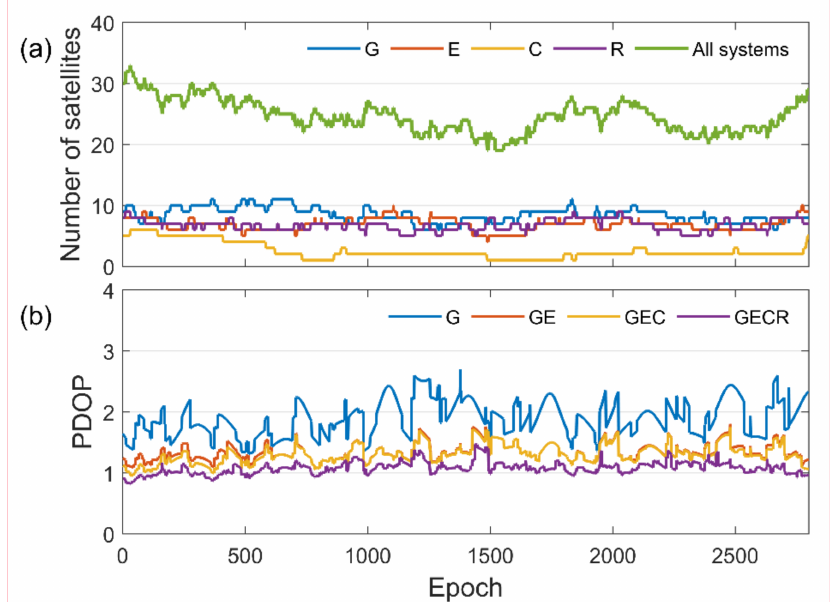
Figure 2. ( a ) Number of satellites and ( b ) position dilution of precision (PDOP) at station